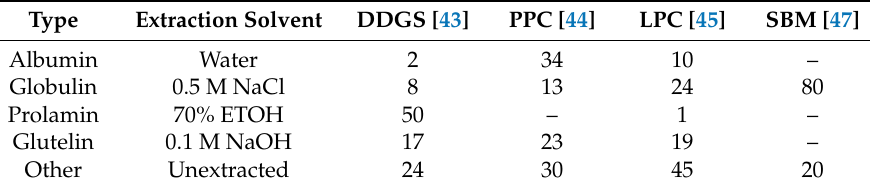
Table 4. Protein types in seed meals based on their percentage of crude protein.